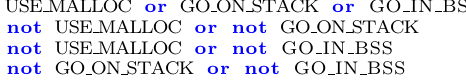
Figure 5. A translation to propositional logic.